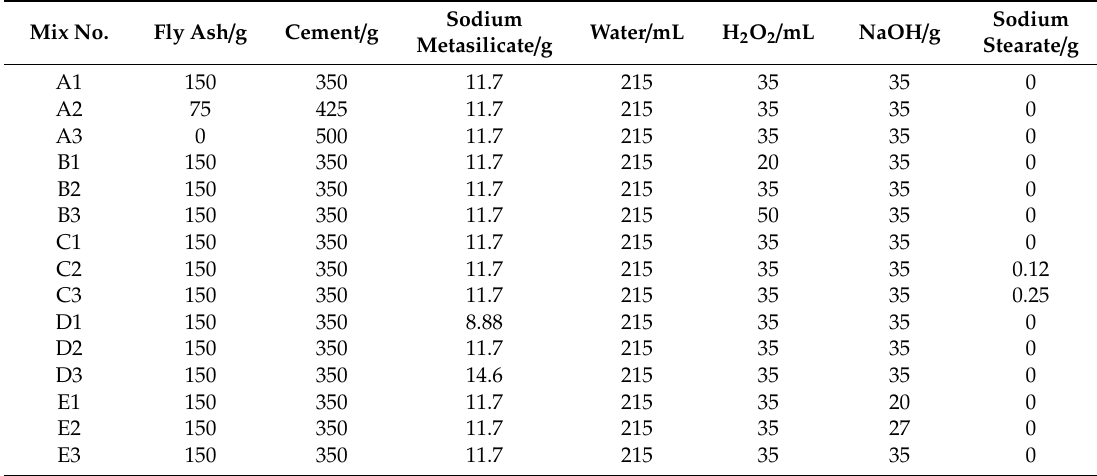
Table 1. Mixture proportion of fly-ash-based foamed geopolymer composites.